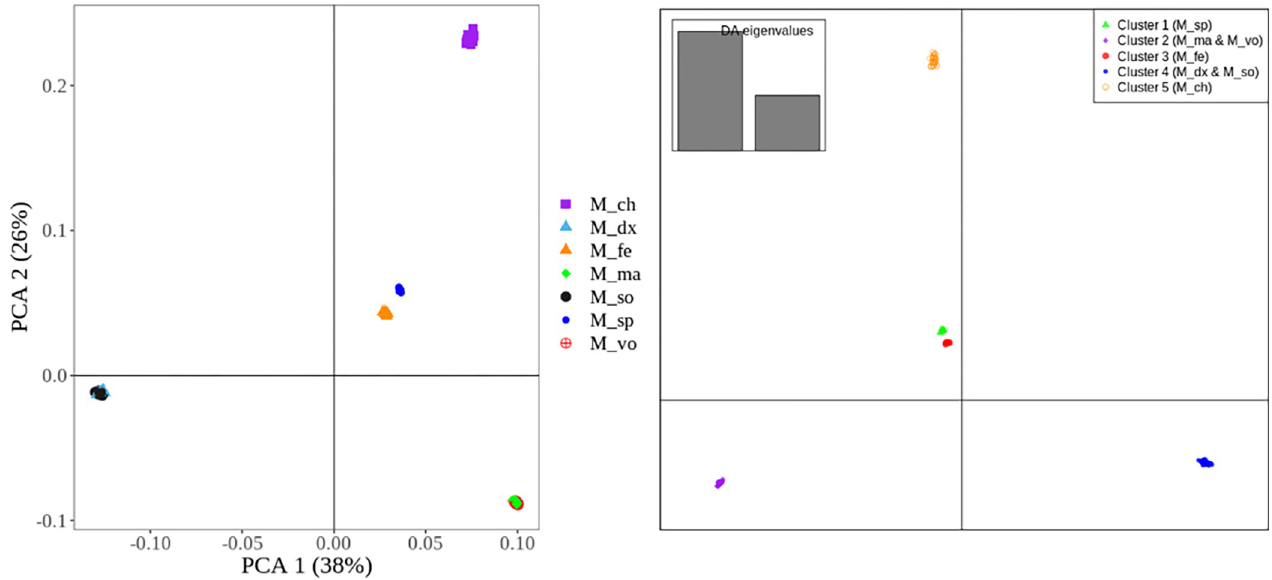
Fig 5. PCA (left plot) and DAPC (right plot) obtained from using a full set of SNPs (N = 1,814). PCA–principal component analysis; DAPC–discriminant analysis of principal components. M_ch–M . chevalieri;M_dx–M . dux;M_fe–M . felicinum; M_ma–M . macrobrachion; M_so–M . sollaudii; M_sp–M . sp; M_vo– M . vollenhovenii